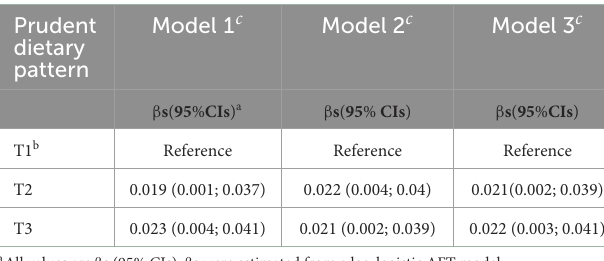
TABLE 4 Associations between tertiles of adherence to the “Prudent” dietary pattern and age at menarche in 215 girls from the Growth and Obesity Chilean Cohort Study.